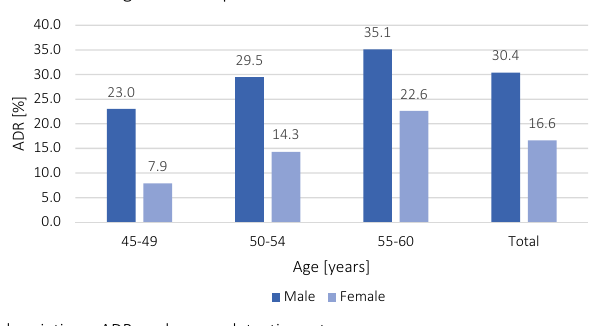
Figure 1. Age and sex specific adenoma detection rate. ADR adenoma detection rate.